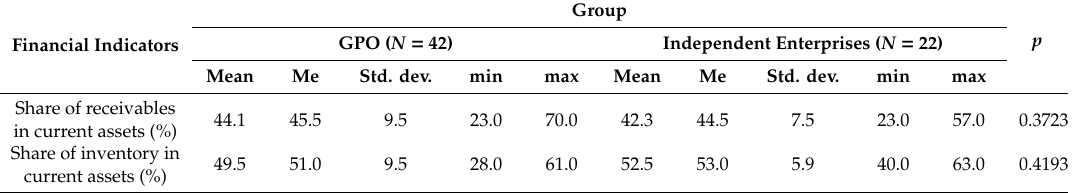
Table 3. Statistics on the distribution of current assets share ratios in both compared groups.